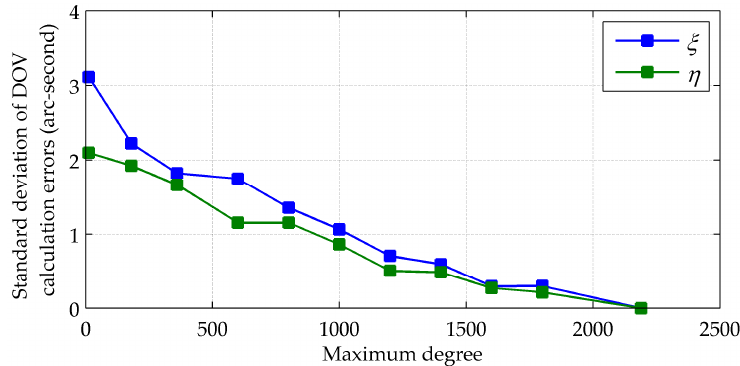
Figure 7. Calculation errors vs. maximum degree.